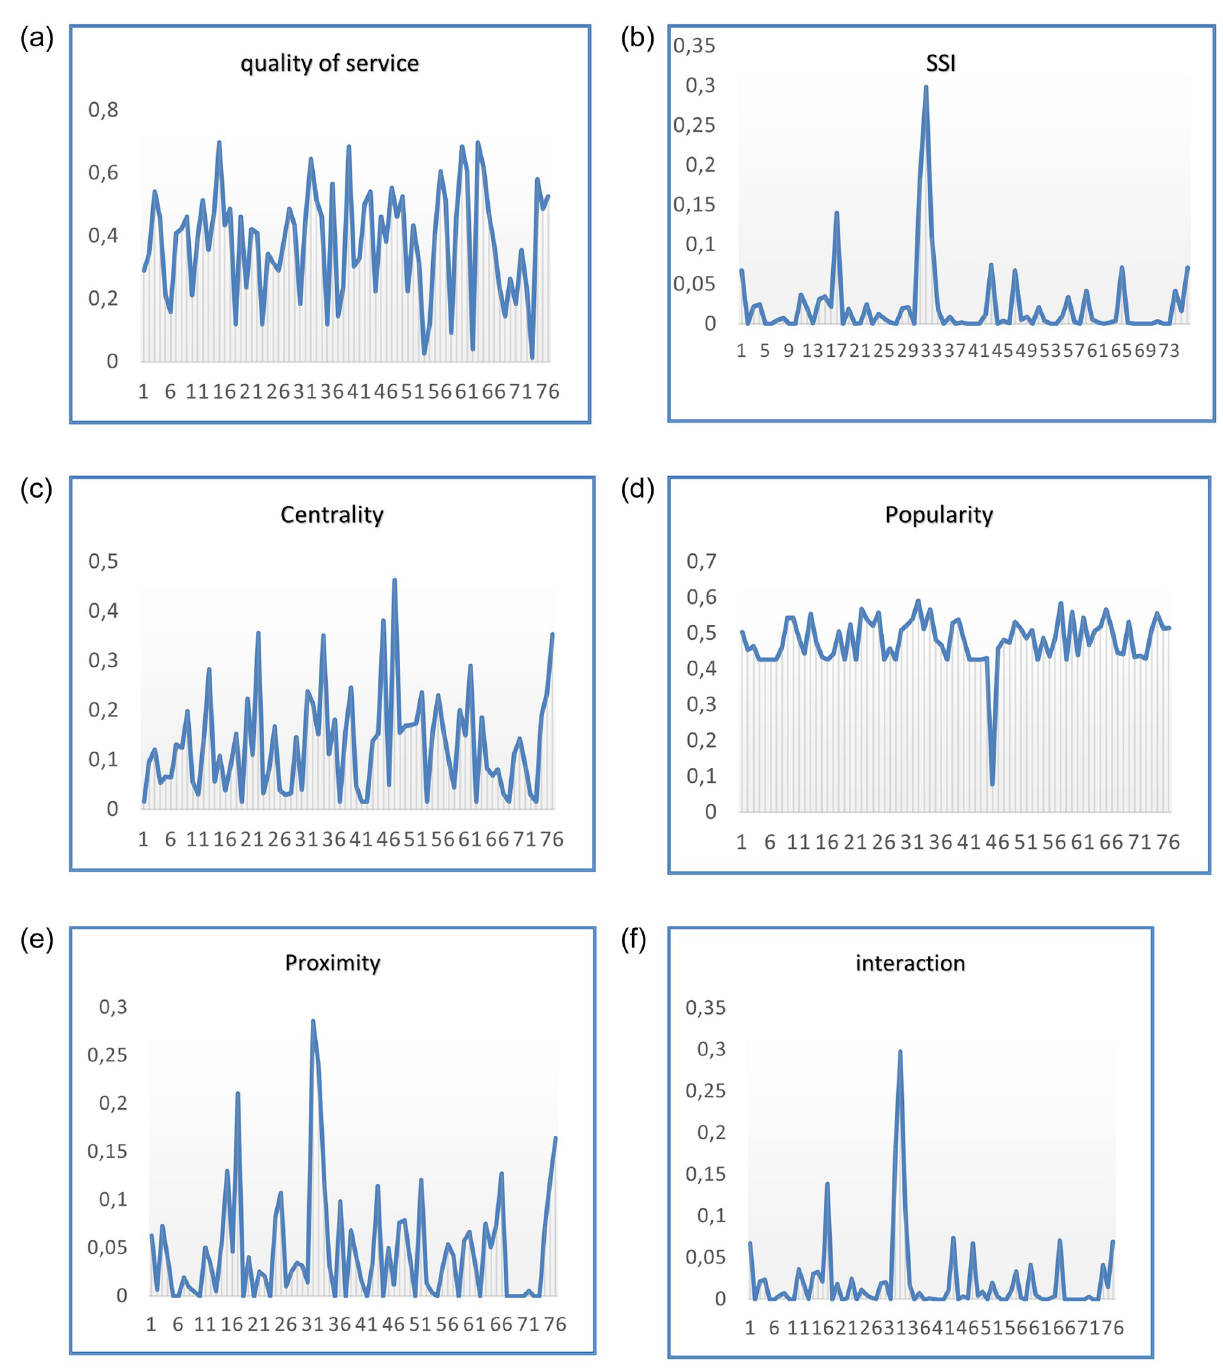
Fig 7. Overview of obtained trust features values per users in the dataset. (a) U63 with the highest rate, (b) U32 as most social, (c) U47 as most central, (d) U32 as most popular, (e) U31 as highest in proximity, (f) U32 as most interactive.